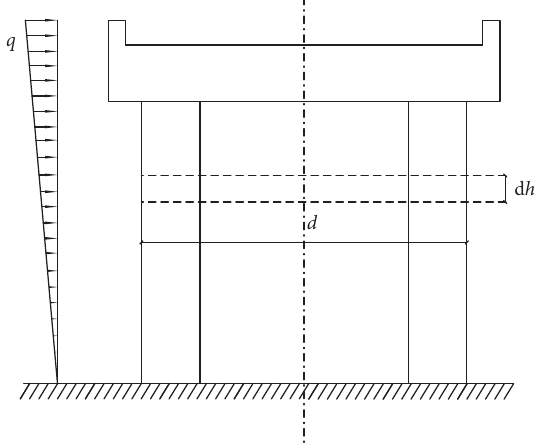
Figure 8: Distribution of flood force on the piers. Table 3: Values of flood forces on Shangban